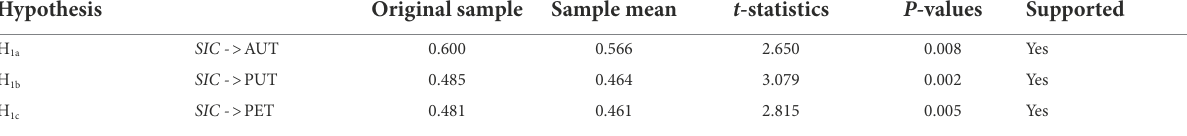
TABLE 9 Direct relationships.